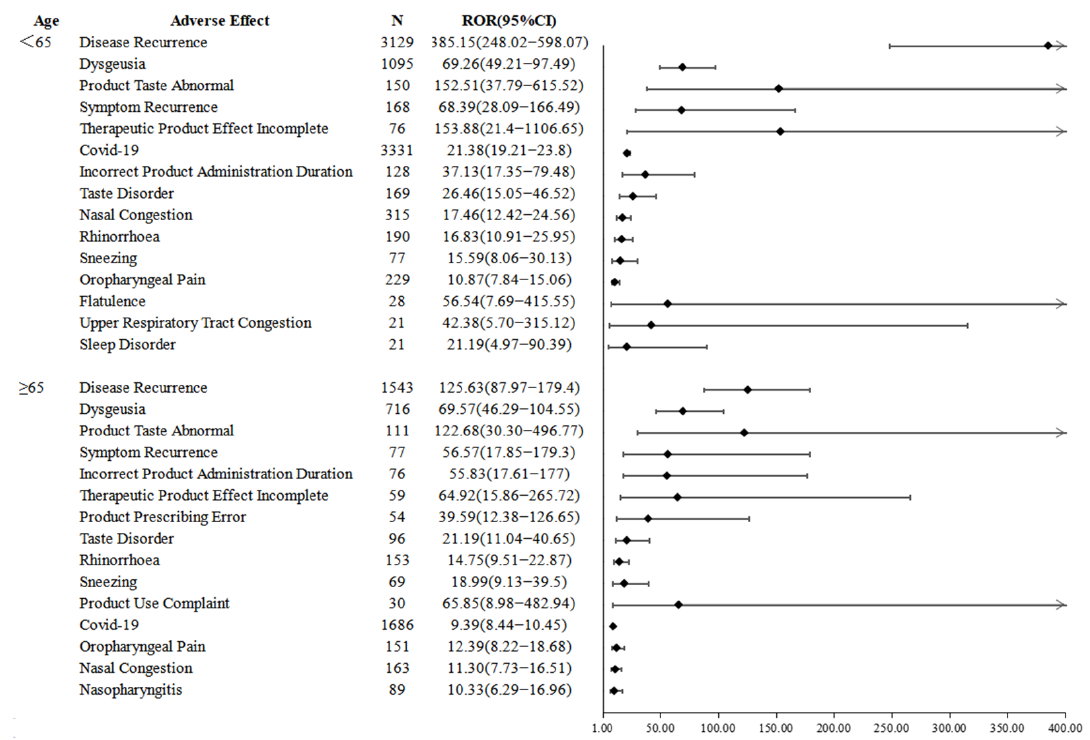
Figure 3. Signals of adverse events associated with nirmatrelvir/ritonavir use based on patient age.